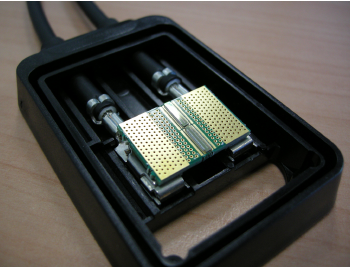
Figure 17. Two parallel NIMBUS chips to be inserted in a standard junction